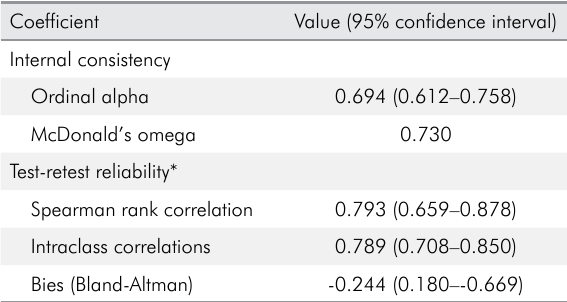
Table 2. Internal consistency and test-retest reliability measurements of the OHQB-Br (n = 156).